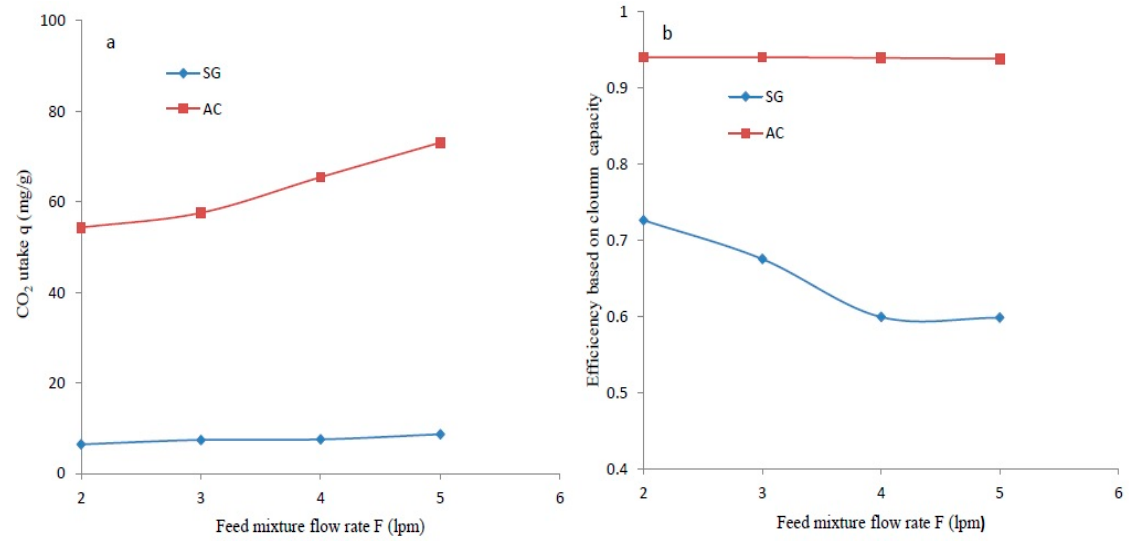
Figure 12. The dependence of the feed rate for SG and AC at C o = 5%, F = 4 lpm on ( a ) CO 2 uptake and ( b ) efficiency.